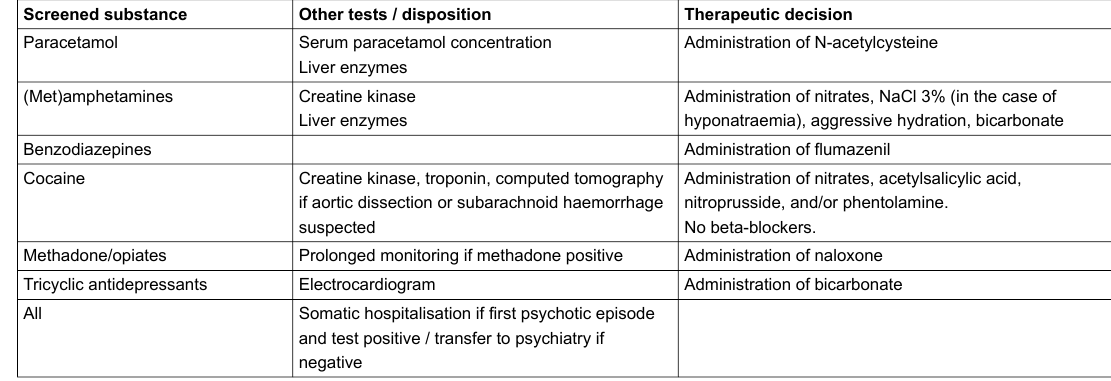
Table 2: Drug specific tests, disposition or therapeutic decisions based on a positive result of the urine drug screening. Screened